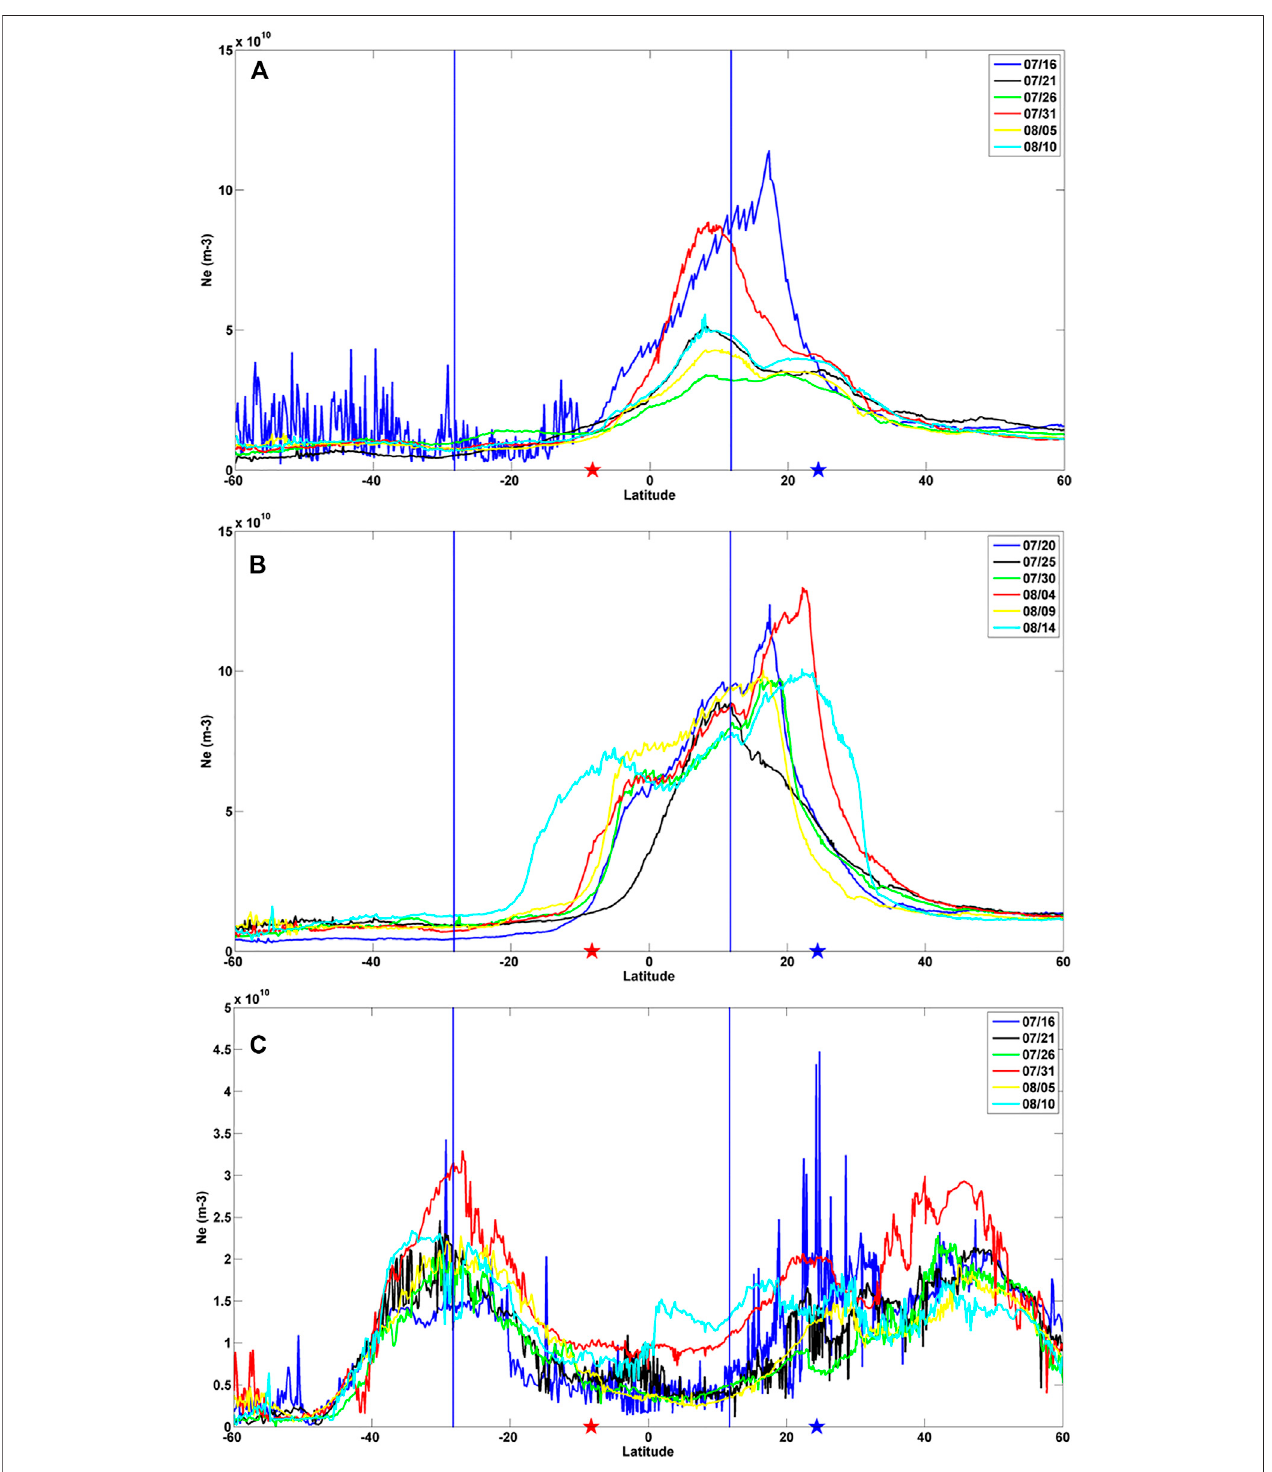
FIGURE5| Electrondensitiesdistributealongthelatitudefortherevisitingorbitsinthedaytimeon31July (A) ,4August (B) ,andinthenighttimeon31July (C) .The red curve representsthe orbit with detected anomalies,and theother color curves representits revisitingorbits whosedatesare marked inthe legend. The red and blue stars represent epicenter and its conjugate point, and two blue lines have the distance of 20 ° away from the latitude of epicenter.